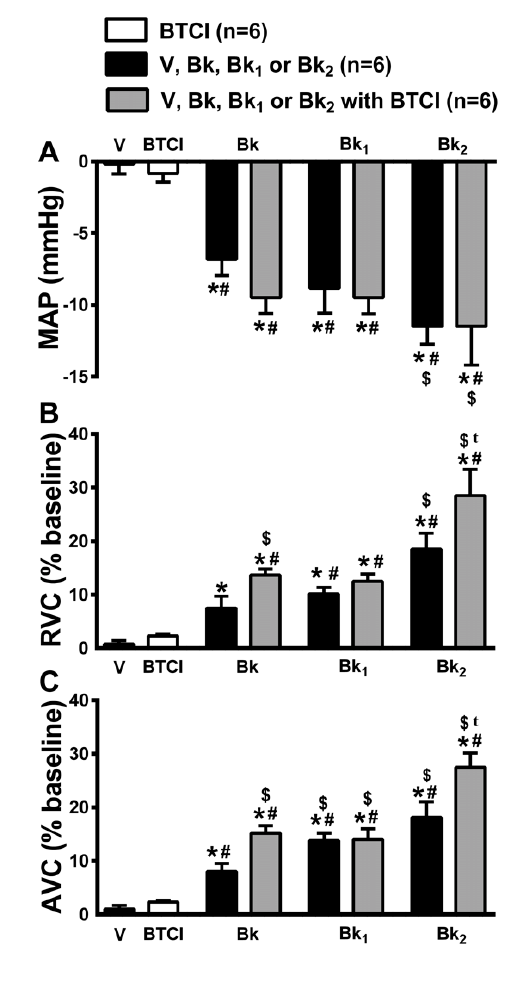
Figure 10. Bk and Bk related peptides and hemodynamic effects. Cardiovascular responses induced by intravenous administration of BTCI (3 µg·kg − 1 of b.wt, in 0.1 mL), Vehicle (V; NaCl 0.9%), Bk, Bk 1 , Bk 2 (120 µg·kg − 1 of b.wt, in 0.1 mL, each) or Bk, Bk 1 or Bk 2